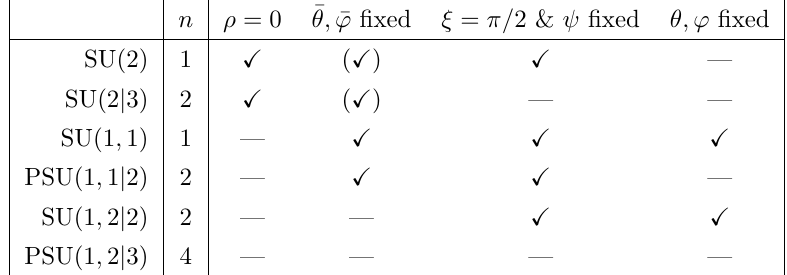
Table 2 . Restrictions of the PSU(1 , 2 | 3) background (3.29) to